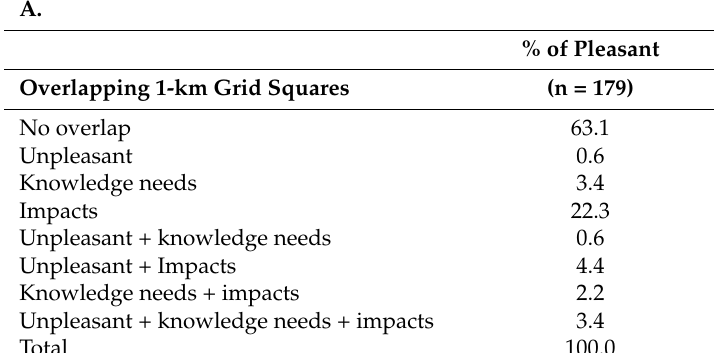
Table 8. Co-occurrence of pleasant places, unpleasant places, places where more knowledge on the state of the environment is needed, and places where positive or negative impacts of mine reopening would be experienced within 1 km grid squares. The proportion of overlapping 1-km grid squares of (A) all pleasant grid squares (n = 179); and (B) all unpleasant grid squares (n = 34).